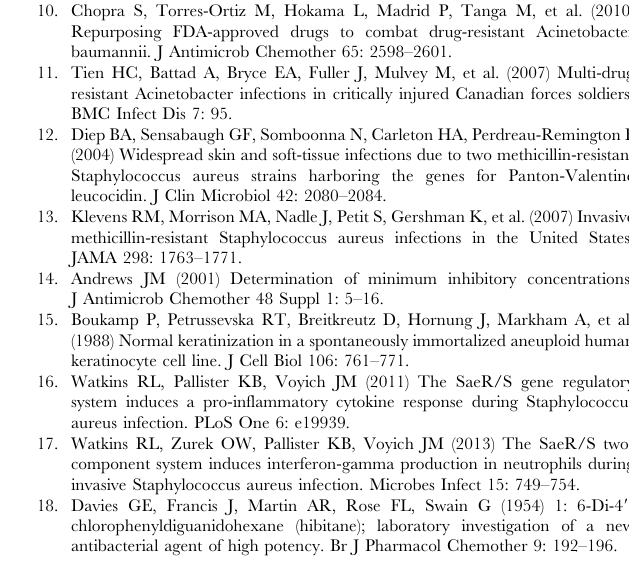
Table S1 Bacterial viability assays. Bacteria were grown at 37 u C to mid-log phase (OD600 , 0.4). The bacteria were diluted to approximately 10 4 to 10 5 colony forming units (CFU) per milliliter and added to a solution of phosphate buffered saline (PBS, 16 mM phosphate, 0.14 M NaCl, pH 7.2) containing the compound at varied concentrations. Samples were incubated at 37 u C for one hour and then plated on Luria Bertani (LB) agar at appropriate dilutions in PBS. The plates were incubated overnight at 37 u C and colonies enumerated the following day. IC50s were calculated from graphs of CFU as a function of compound concentration. Chlorhexidine was used as a positive control. Included are those guanide (G), biguanide (BG), phenylguanide ( W G) compounds that had some antibacterial activity in an initial screen at 30 and 100 m M, as well as their and parent amines. Compounds synthesized from 1,4-butanediamine, 1,6-hexanedia- mine, trisethylaminomelamine, trisbutylaminomelamine, and the dendrimer PAMAM (G0) were not active against E. coli, P aeruginosa , or S. aureus so they were not tested against the remaining bacteria (data not